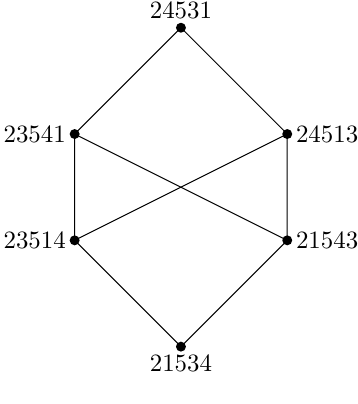
Fig. 5: The interval [21534 , 24531] ⊂ S 5 , which is isomorphic to S 3